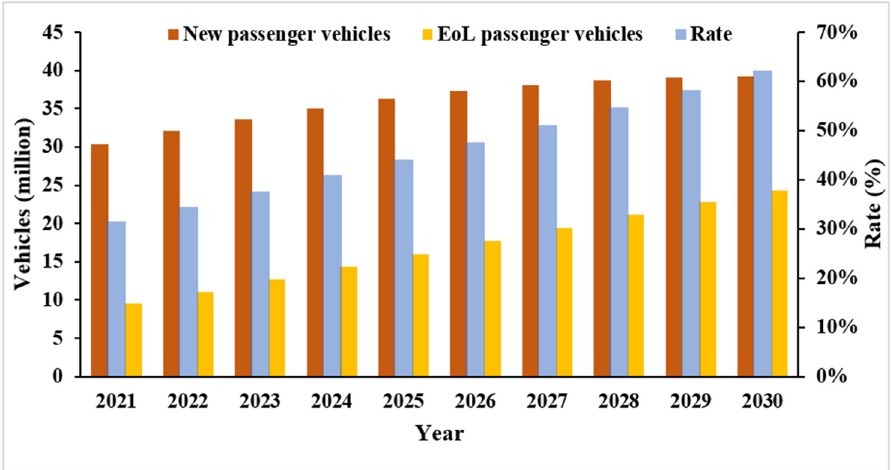
Figure 3. Estimations of new passenger vehicle demand and EoL passenger vehicles from 2021 to 2030 (under the BAU scenario).